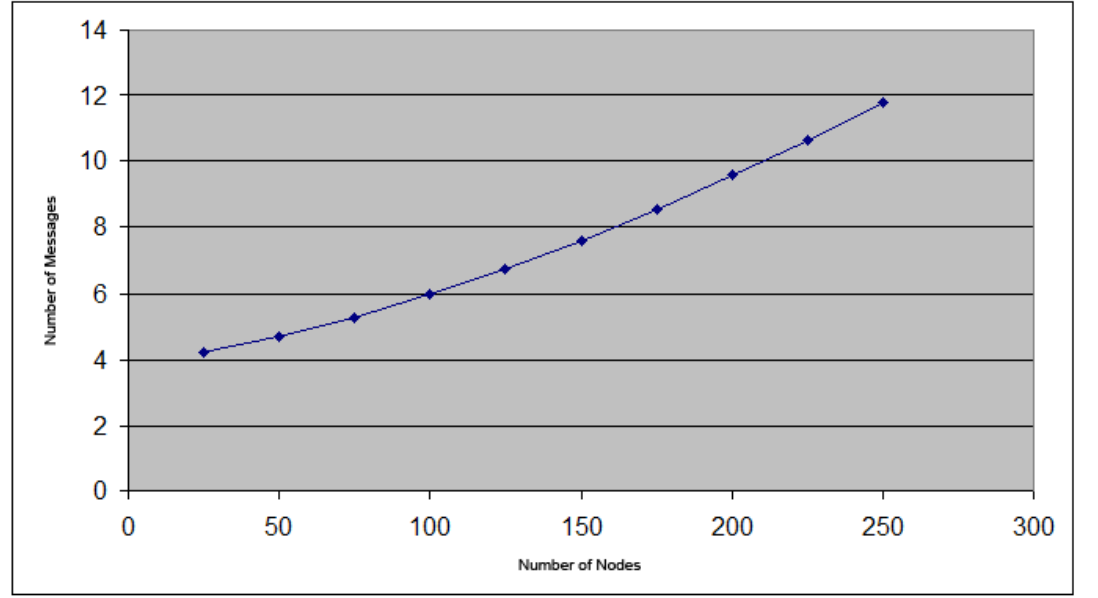
Figure 13. Control message average number sent in each address configuration.